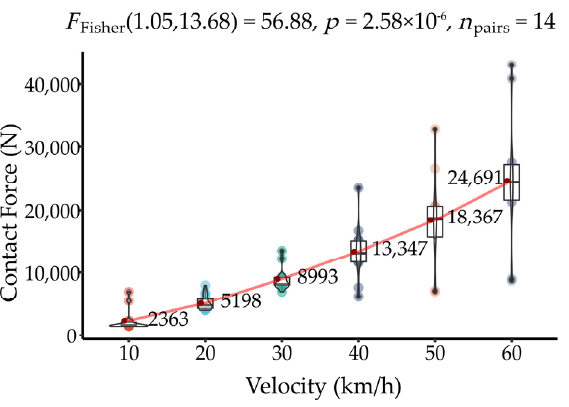
Figure 13. The contact force increased with the increasing loading velocity.